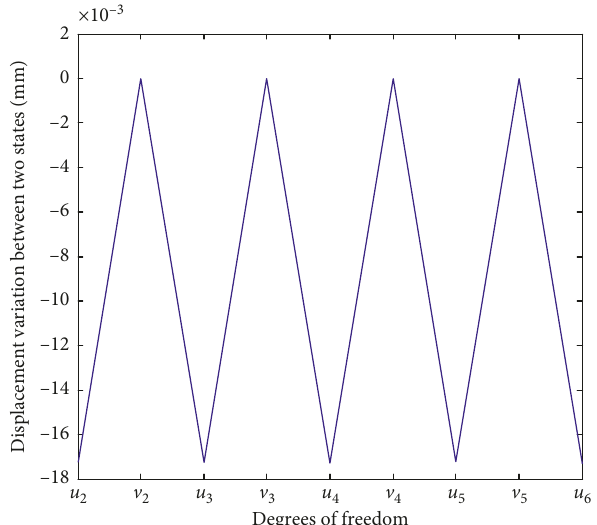
Figure 3: Difference between actual and estimated responses of the truss